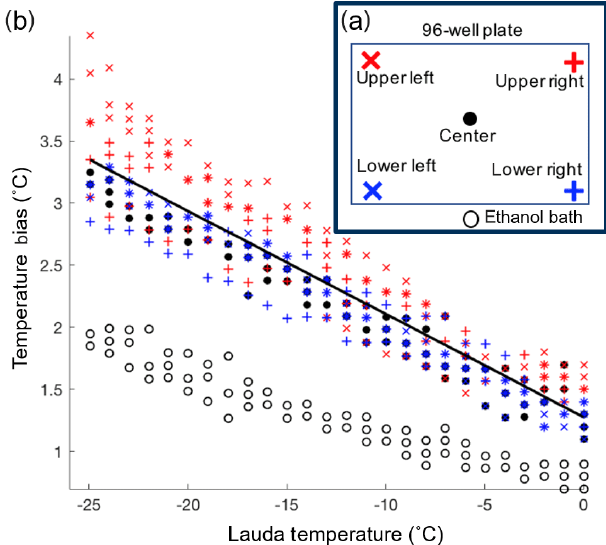
Figure 3. (a) Locations of the type-K thermocouples tested dur- ing the temperature calibration. Additionally, the temperature dif- ference between the LAUDA temperature and the ethanol bath was measured at the indicated location (black open circle). (b) The tem- perature bias between the wells and ethanol bath is displayed versus the LAUDA bath temperature. The linear temperature correction is shown in